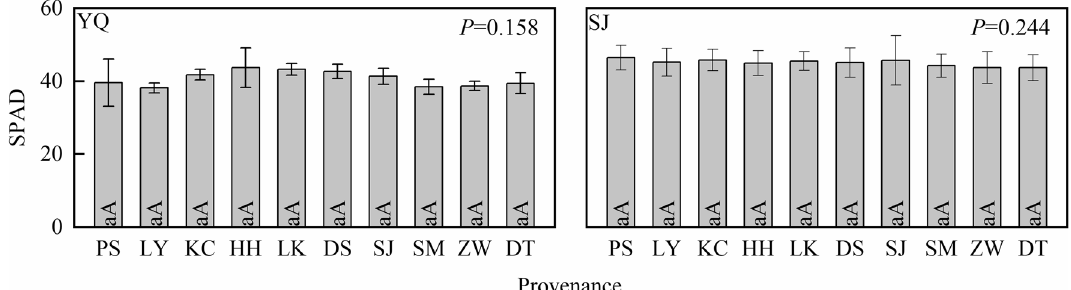
Figure 2. Relative chlorophyll content analysis of Quercus liaotungensis seedlings between provenances. YQ represents the Yangqu test site, and SJ represents the Sanjiao test site. Different lowercase letters indicate a significant difference at the 0.05 level, and uppercase letters indicate a significant difference at the 0.01 level.